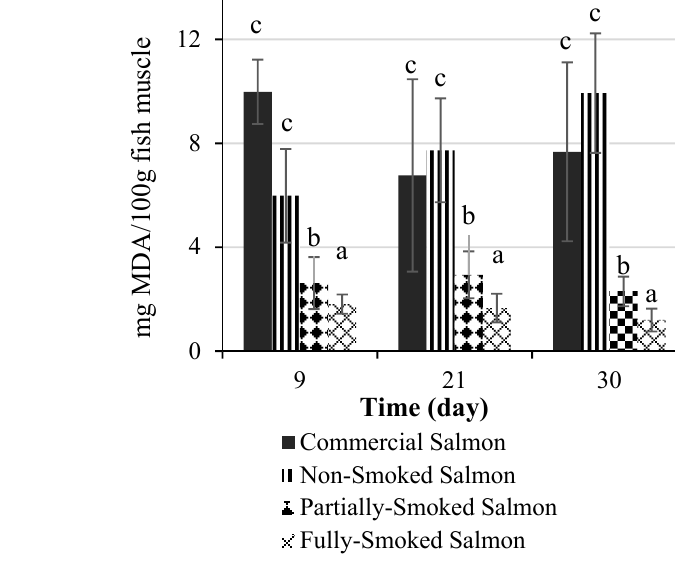
Figure 1. ( A ) Lipid hydroperoxide content in commercial and FN non-smoked and FN half-smoked and fully smoked FN salmon versus storage time (days); ( B ) Malonaldehyde (MDA) content in commercial and FN non-smoked salmon and FN half-smoked and fully smoked FN salmon during storage time (days). Values represent mean ± SD ( n = 3). Superscripts with different alphabets (a–c) are significantly different ( p < 0.05).